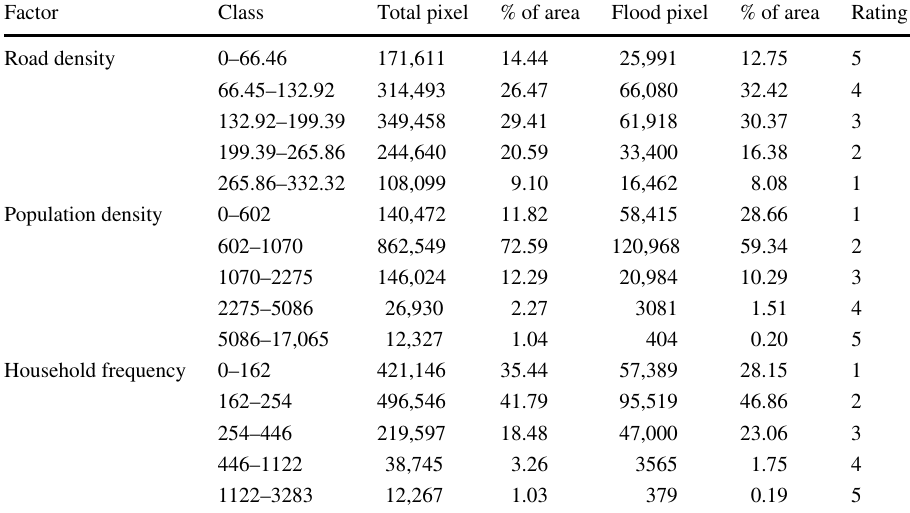
Table 3 Assignment of weight to sub-class of individual parameters used